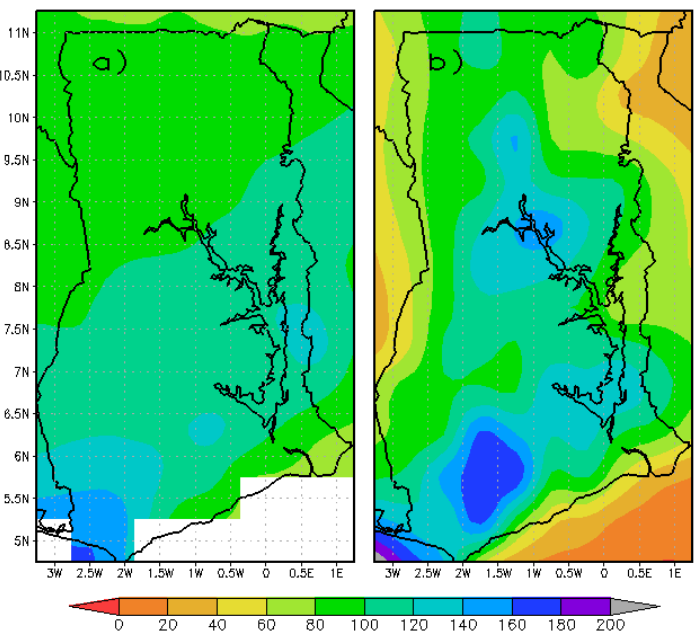
Figure 3. Comparison of GPCC and GMet data from 1980-2010. In ( a ), the Multi-year mean of monthly rainfall totals (mm) over Ghana from GPCC data; ( b ) shows the Multi-year mean of monthly rainfall totals (mm) over Ghana from GMet data.